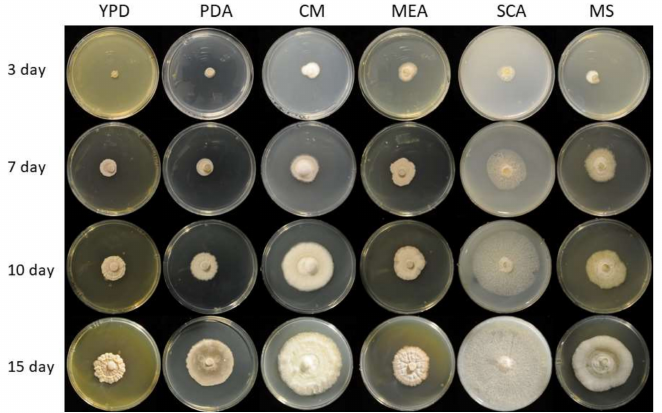
Figure 1. Images of S. longicolleum FW57 (DSM105789) mycelia on six different media over 15 days. The selected media were potato dextrose agar (PDA), yeast extract peptone dextrose (YPD), complete medium (CM), malt extract agar (MEA), starch casein agar (SCA) and Mandels’ mineral salts